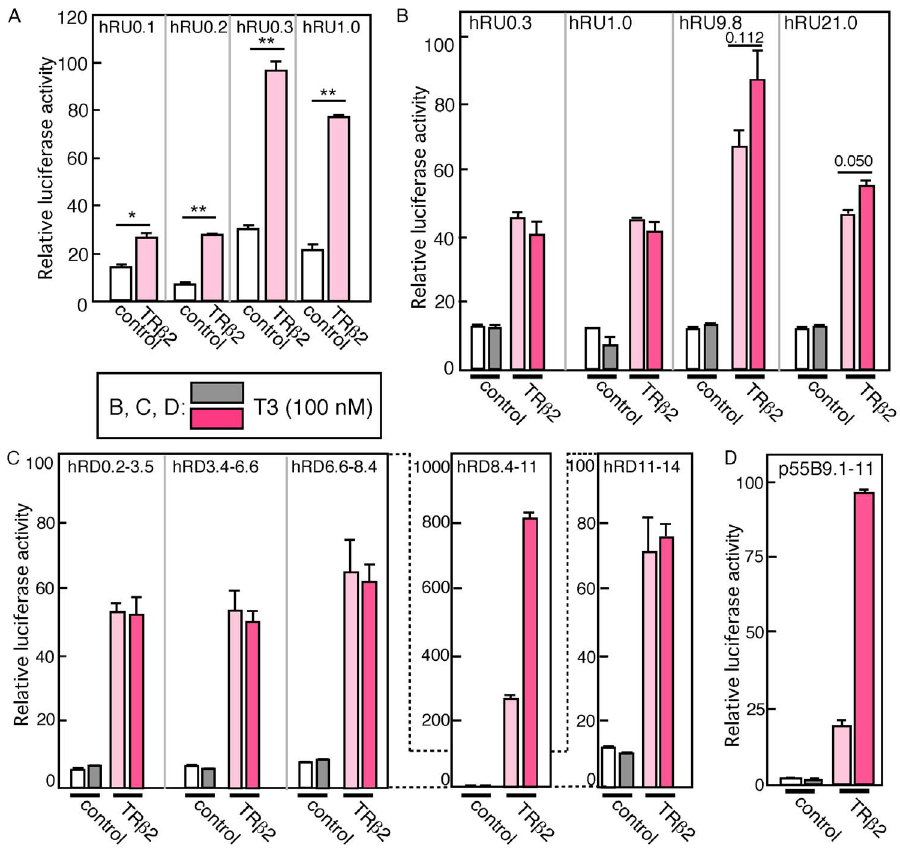
Figure 2. Effects of TRß2 and T3 on human red opsin promoter activities. Luciferase plasmid was transfected into HEK293T cells with TRß2 expression vector or a control vector, and cells were harvested after 28 hours of incubation. Luciferase activities were examined and expressed as relative values. A. Luciferase plasmid containing 5 9 proximal promoter region was transfected with TRß2 expression plasmid or control vector. B–D. Luciferase plasmids containing 5 9 promoter region (B), exon/intron region fused with 1.0 kb proximal promoter region (C), or p55Bluc vector (D) was transfected into HEK293T with TRß2 expression plasmid or a control vector, and cultured for 12 hours, then cultured additional 16 hours in the presence or absence of T3 (100 nM). Luciferase activity was examined and expressed as relative values. Pink colored bars indicate samples transfected with TRß2, and dark grey and dark pink show those with stimulation by T3. p value; ** , 0.01, * , 0.05, or actual value was calculated by Student’s t- test.